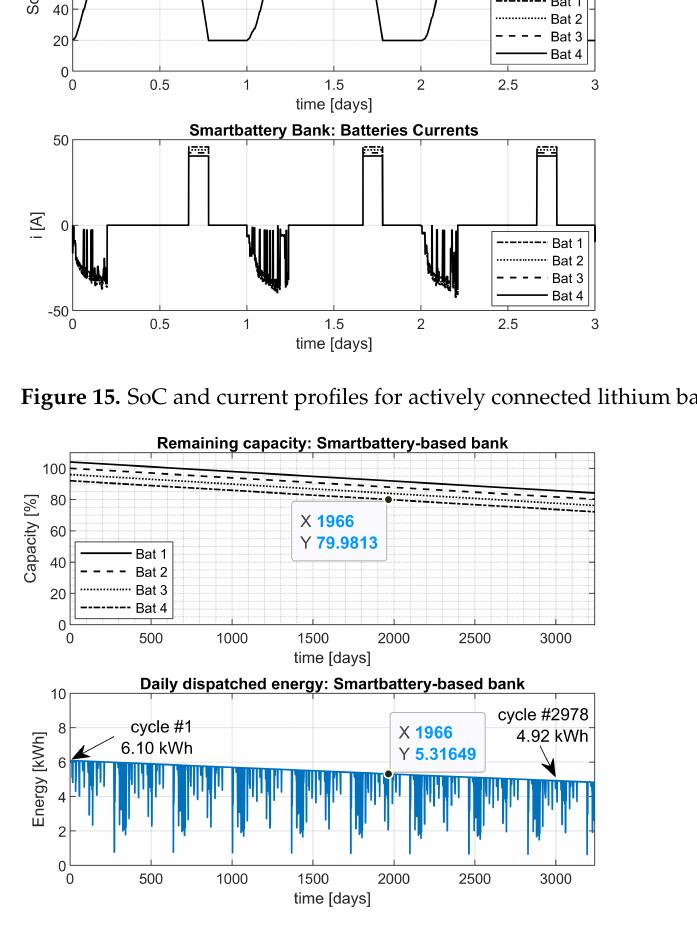
Figure 16. Battery capacity losses and daily dispatched energy (active lithium battery